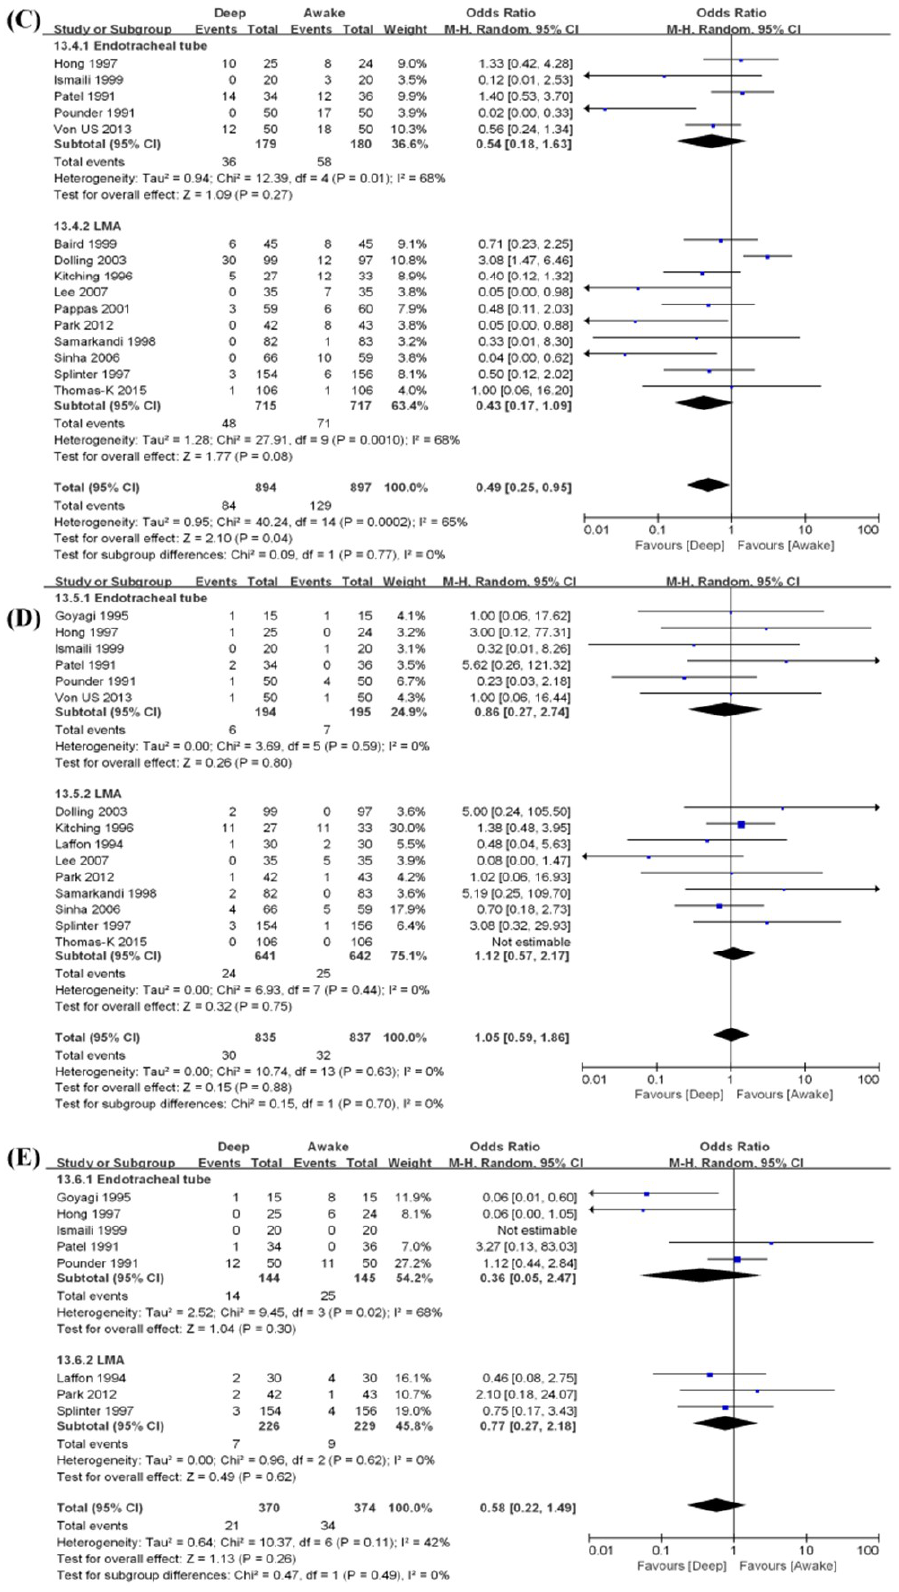
Figure 4. Forest plot of comparison. Deep extubation (experimental) vs. Awake extubation. (control). Outcome: ( A ) Airway obstruction, ( B ) cough, ( C ) desaturation, ( D ) laryngospasm, and ( E )